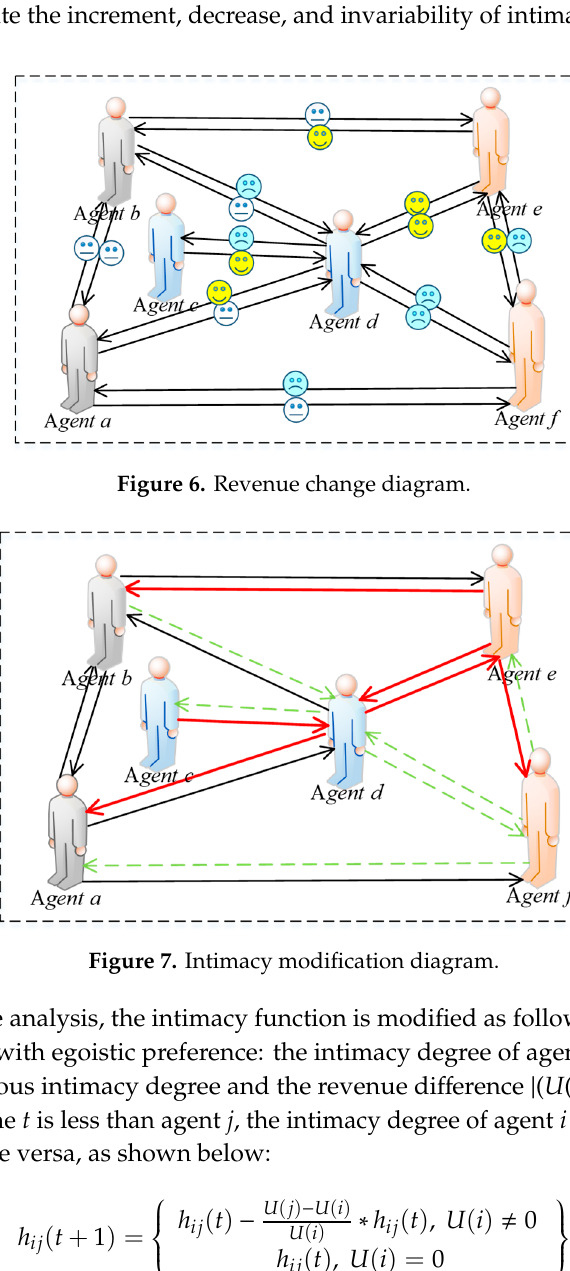
Figure 7, the solid red arrow, the dotted green arrow and the solid black arrow indicate the interaction intention, respectively. In Figure 7, the solid red arrow, the dotted green arrow and the solid black arrow indicate the increment, decrease, and invariability of intimacy increases, respectively.